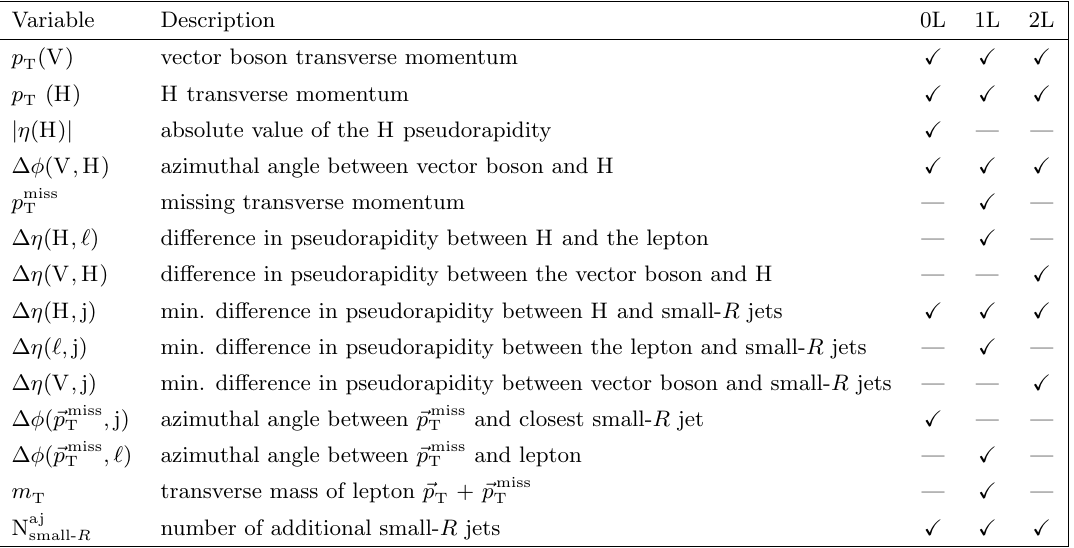
Table 2 . Variables used in the kinematic BDT training for each channel of the merged-jet topology